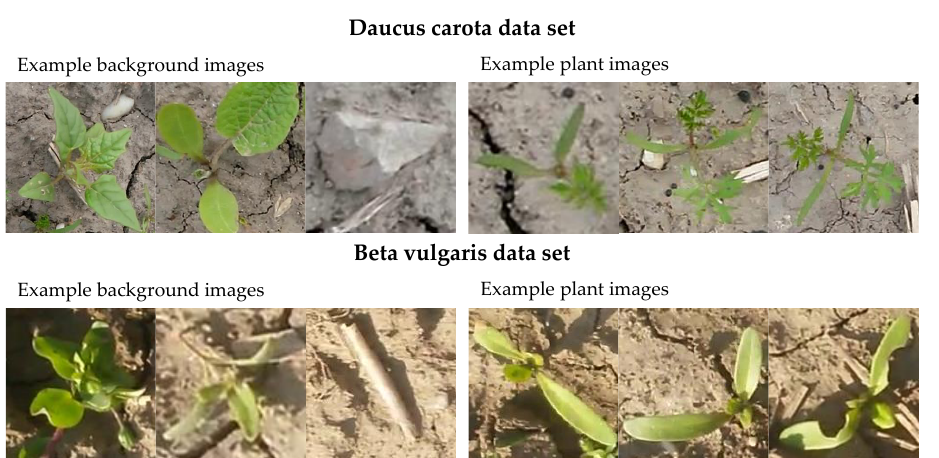
Figure 1. Randomly chosen example images of both used datasets. The left side shows three background images (soil, other plants, etc.) and the right images show example images of the plant to